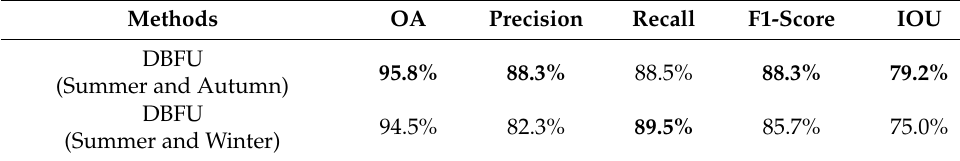
Table 6. Comparison of accuracy of different seasonal combinations of